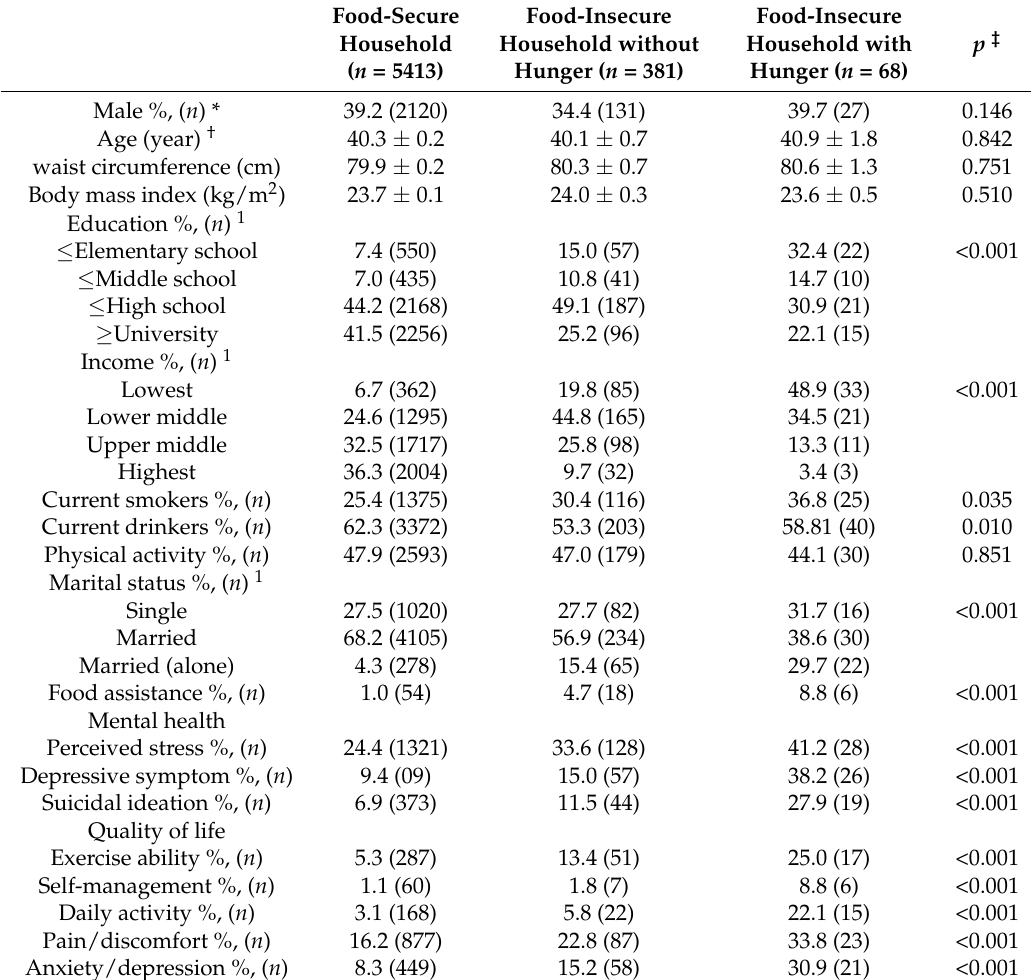
Table 1. General characteristics of participants per types of household food security. Food-Secure Household ( n = 5413)